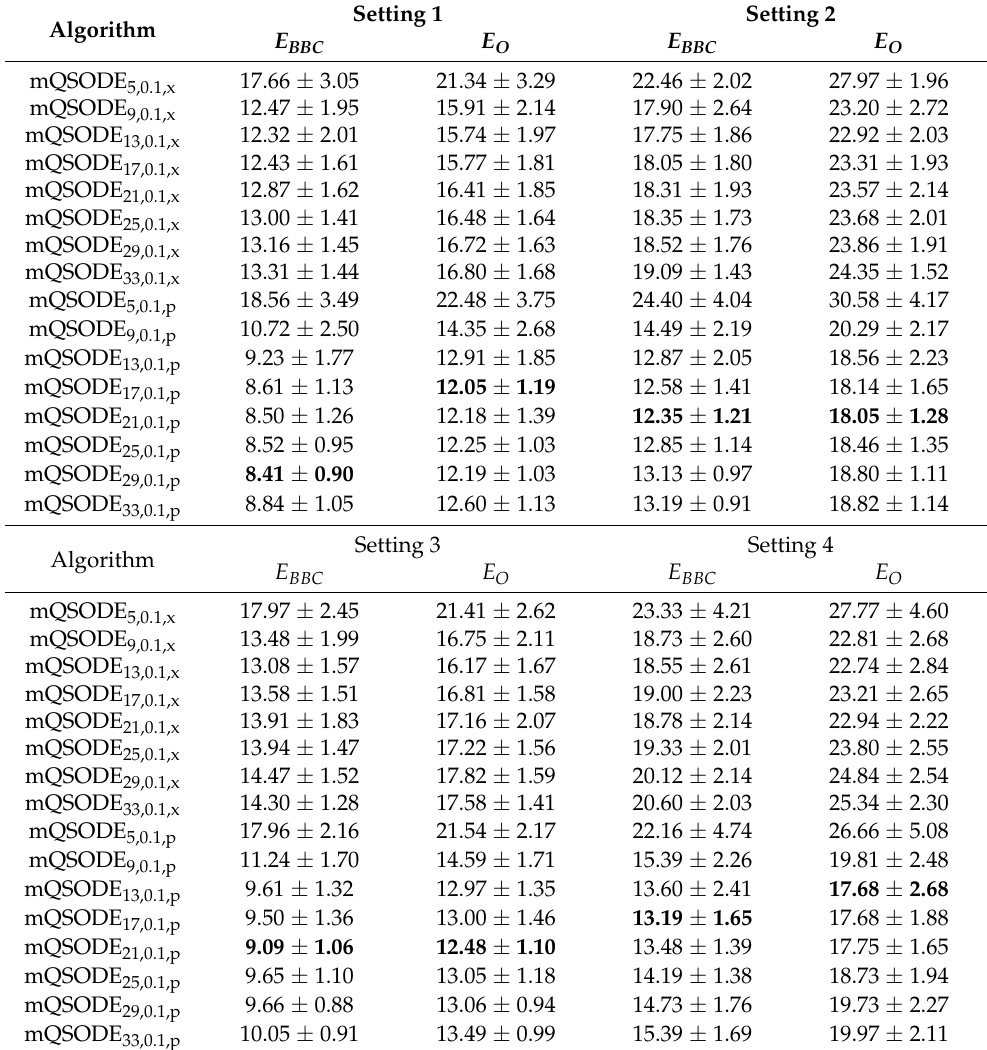
Table 4. Comparison of mQSODE with current and personal best positions in